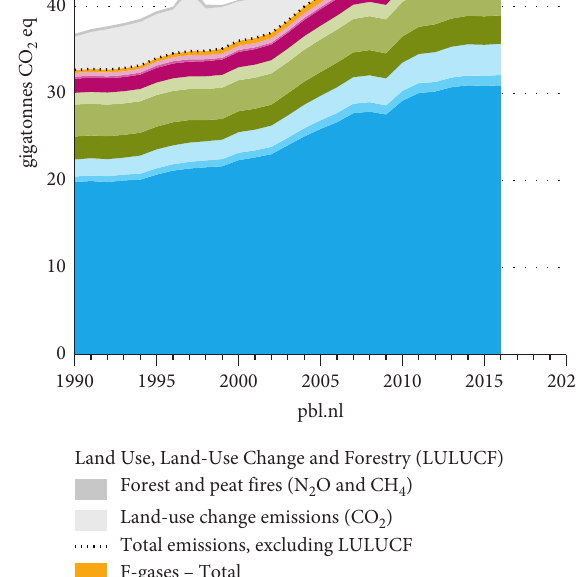
Land Use, Land-Use Change and Forestry (LULUCF)